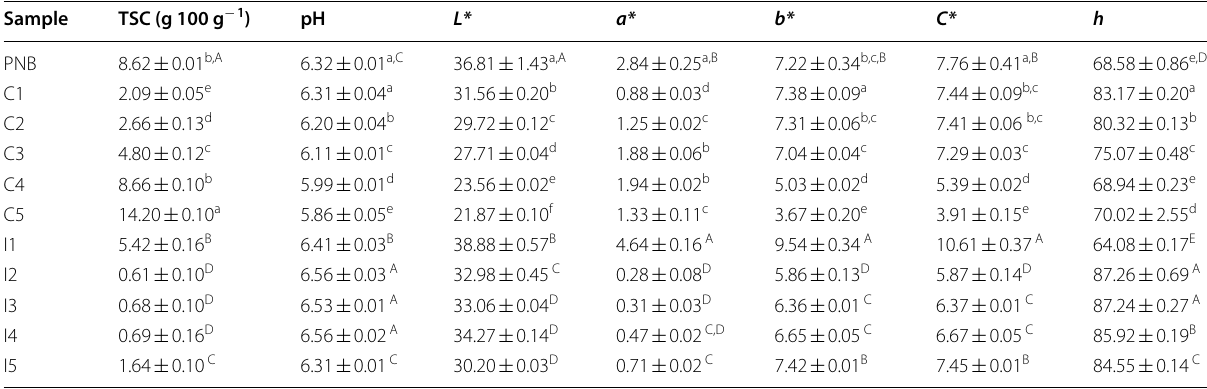
L *, a * and b *, CIELab parameters; C*, chroma; h , hue angle Significant differences ( P < 0.05) between concentrate (C1-C5) and ice (I1-I5) fractions compared to PNB in each column are indicated lowercase and capital letters,